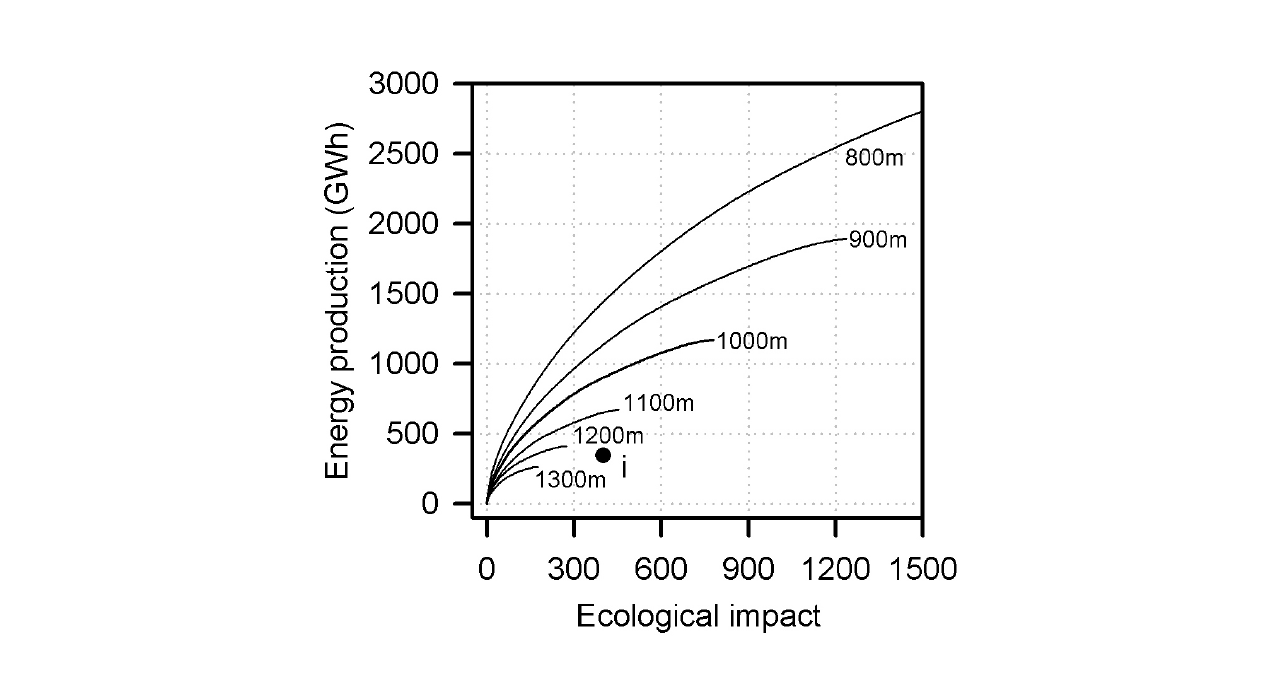
Fig. 7 . Efficiency frontiers for different settlement distances. Settlement distances increase from top to bottom in steps of 100 m from 800 m to 1300 m. Point i represents the current situation in the study